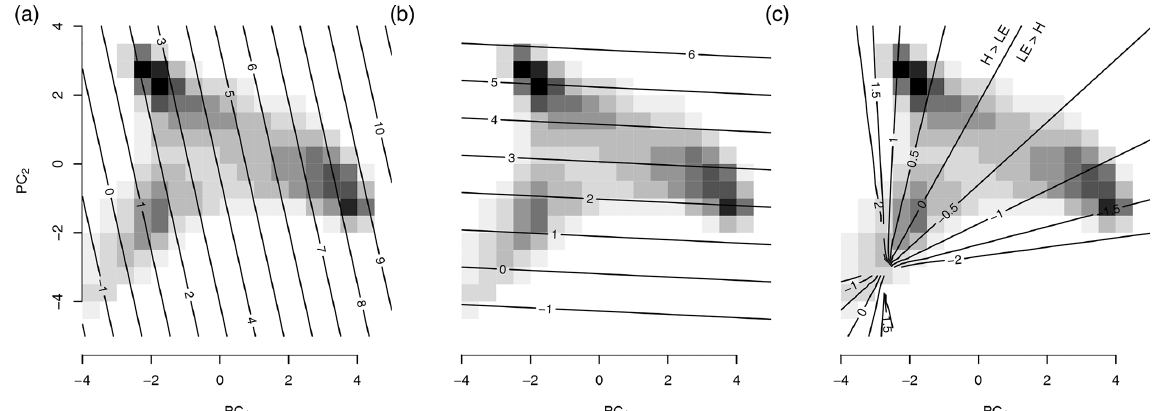
Figure 5. The background shading shows the distribution of the mean seasonal cycle of the spatial points (see Fig. 4). The contour lines represent the reconstruction of the variables from the first two principal components. The reconstructed variables are (a) latent heat (LE), (cid:17) (cid:16) SensibleHeat (b) sensible heat (H), and (c) log 10 , the log 10 of the Bowen ratio. Note that the LE and H have been considered in the LatentHeat construction of the PCs and hence are a linear function of the PCs. The Bowen ratio, instead, was not considered here and clearly responds in a nonlinear